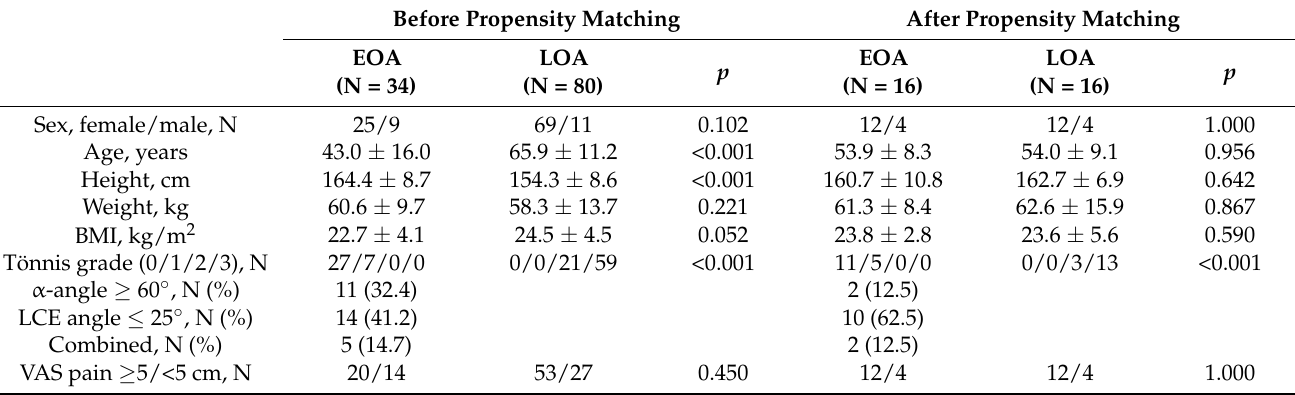
Table 1. Clinical characteristics in early and late hip osteoarthritis patients before and after propensity matched score analysis.